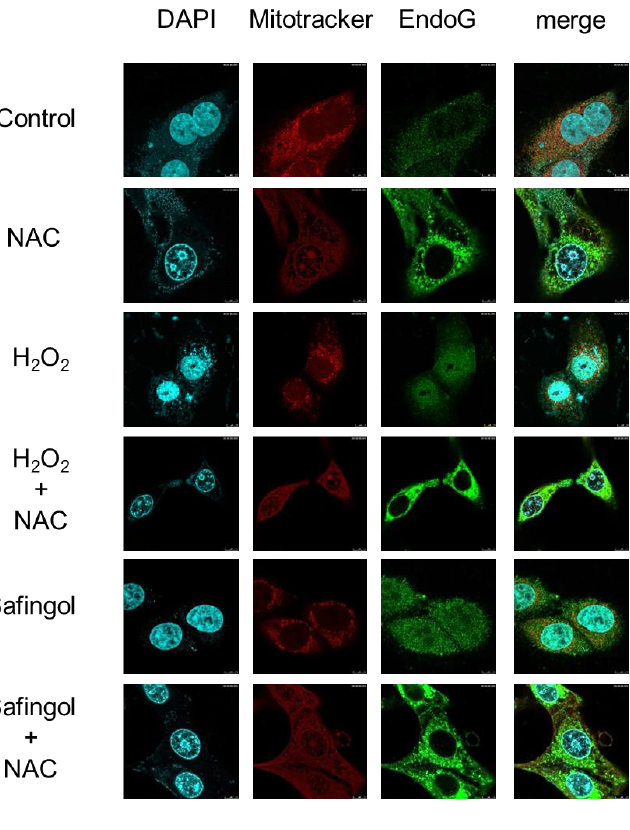
Figure 5. Translocation of endo G by H O and safingol. SAS cells were treated with 2 2 100 µM H O or 15 µM safingol in the presence or absence of NAC for 12 h. They were 2 2 subjected to immunofluorescent staining using DAPI, antibody against endo G and Mitotracker Red CMXRos DAPI. Untreated cells were also stained. The imaging of each staining was merged. At least three measurements were performed. A representative result is